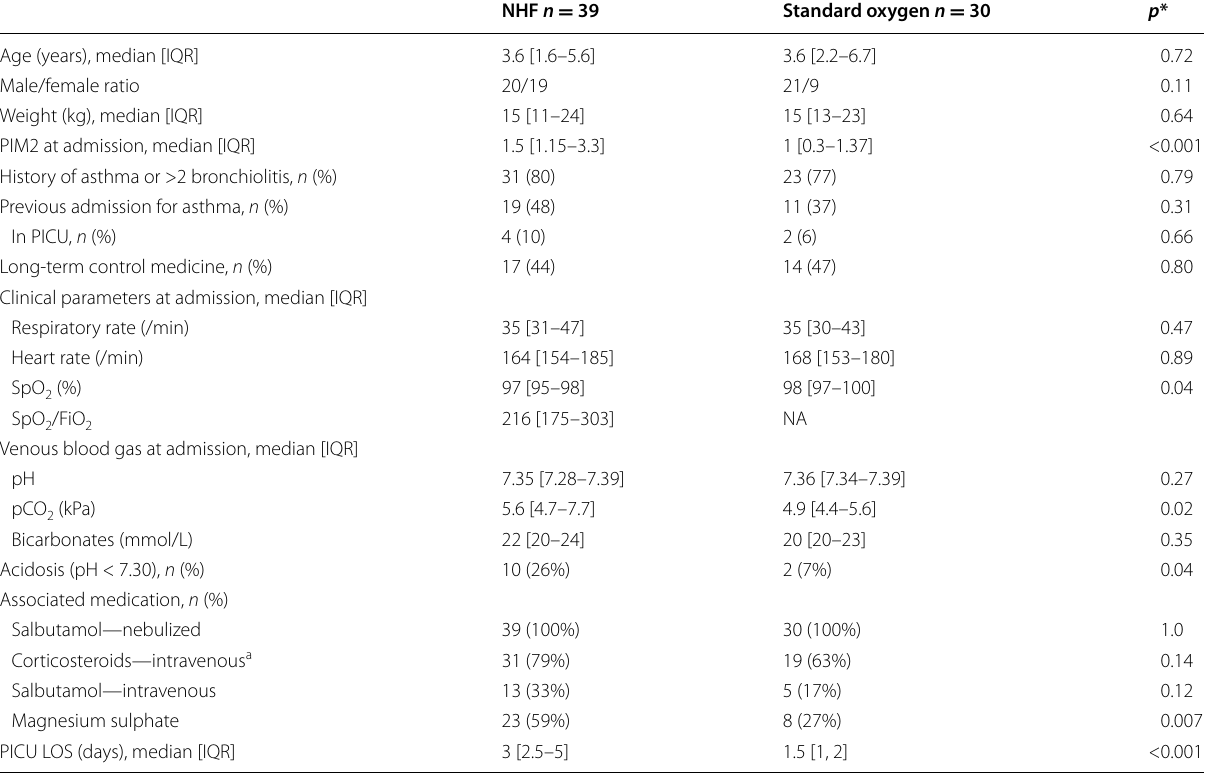
Table 1 Baseline characteristics of children treated with nasal high flow and with standard oxygen therapy for status asthmaticus